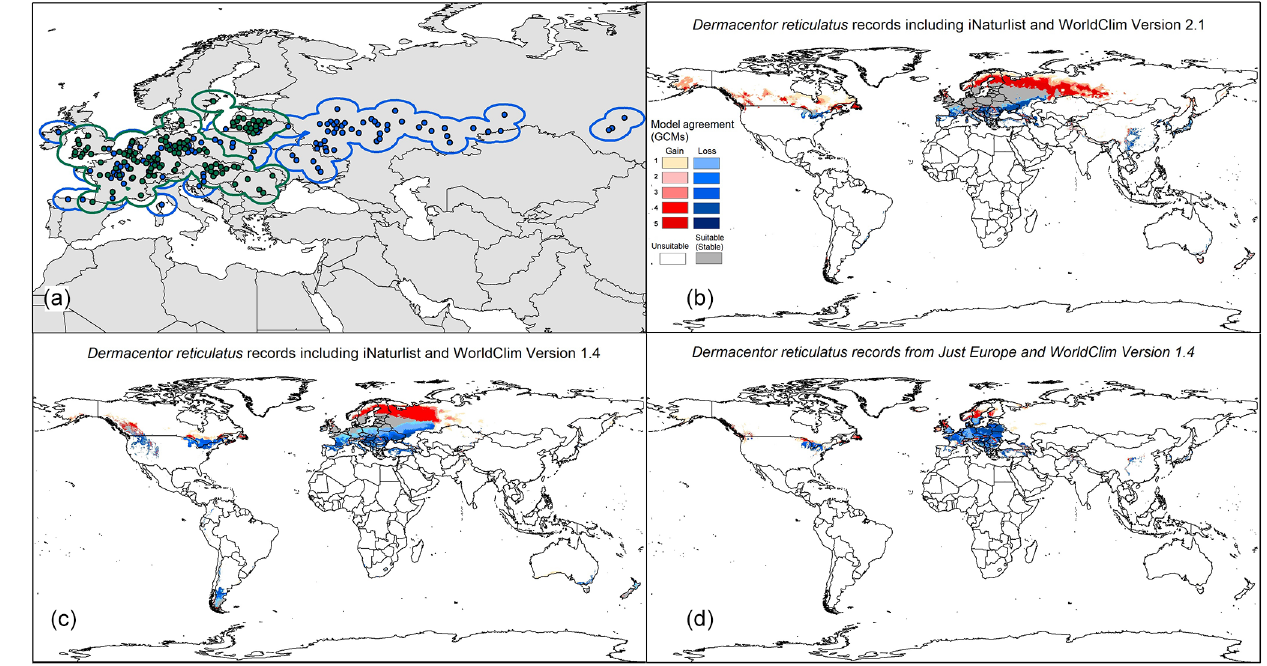
Figure 6. Comparison among three different models for Dermacentor reticulatus . (a) Old occurrence points in green dots and new occurrence points in blue. (b) Model transfer globally under current and future conditions using WorldClim version 2.1 and iNaturalist data from GBIF. (c) Model transfer globally under current and future conditions using WorldClim version 1.4 and iNaturalist data from GBIF. (d) Model transfer globally under current and future conditions using WorldClim version 1.4 and old data from GBIF (without iNaturalist